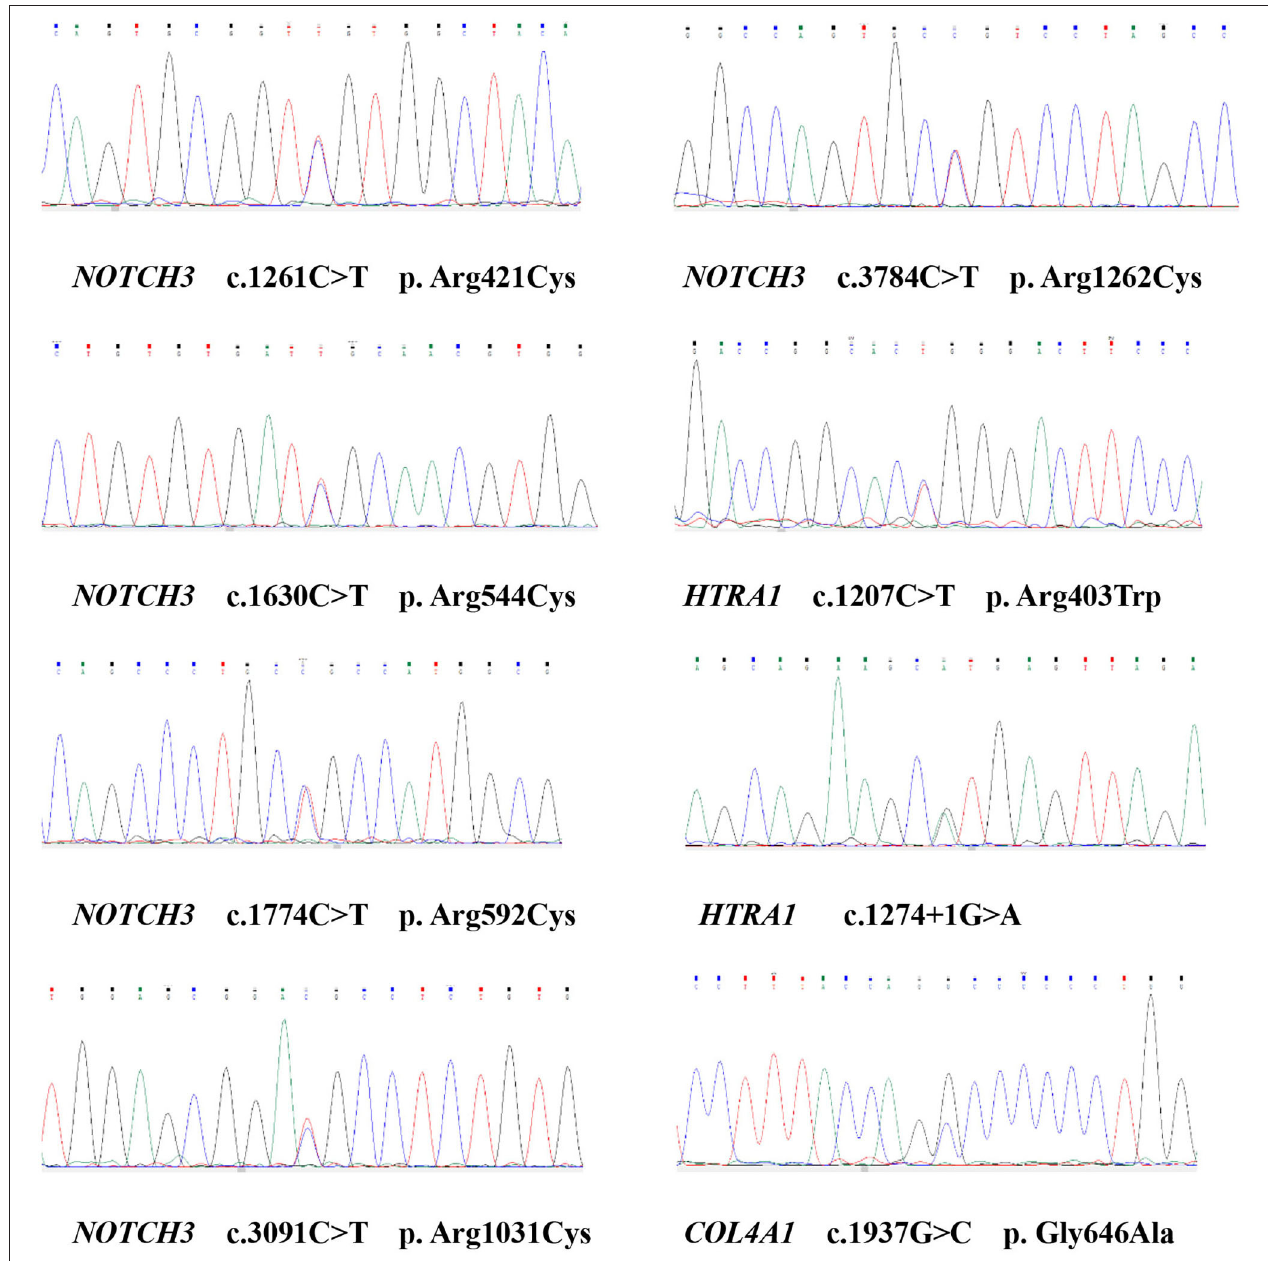
FIGURE 2 | Sequencing chromatograms showed the variants of the NOTCH3 , HTRA1 , COL4A1